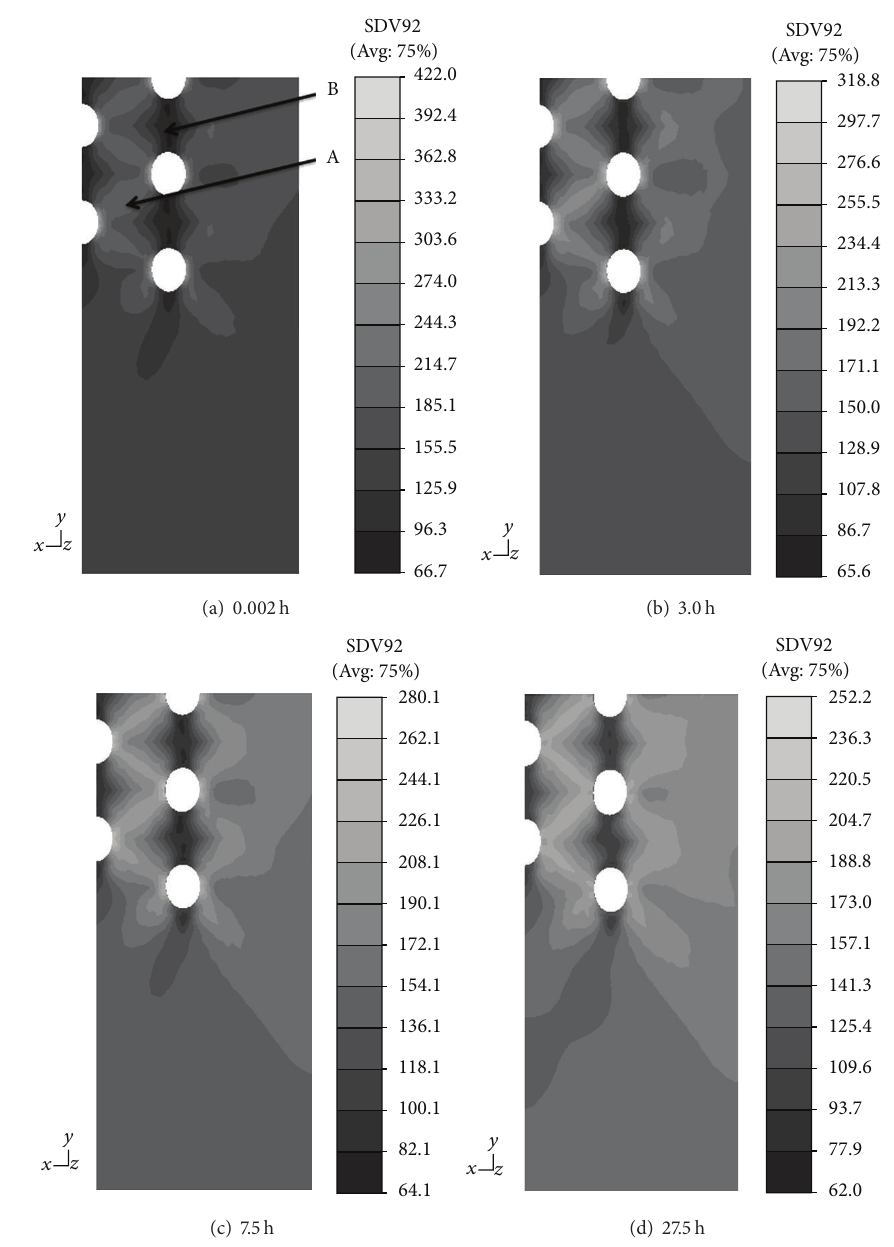
Figure 2: The development of the maximum resolved shear stress at different creep